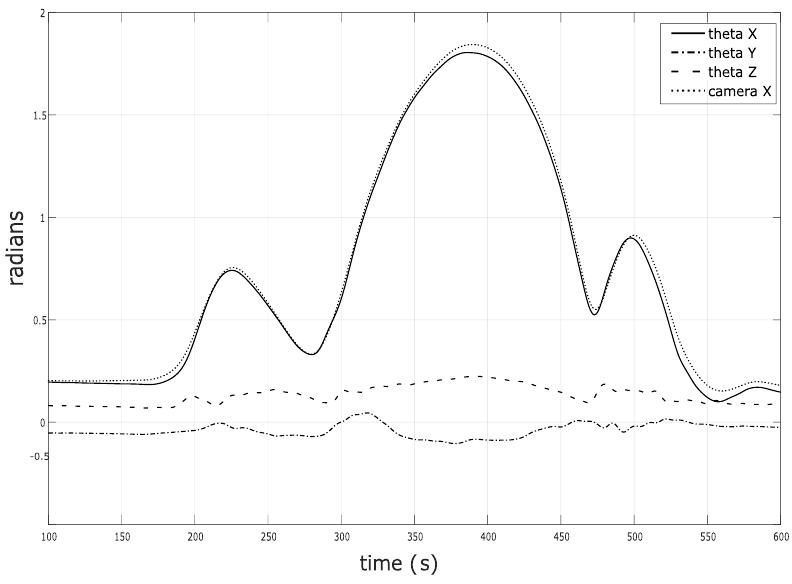
Figure 8. Estimated angles from a lunge movement. The estimated X (flexion/extension), Y (varus/valgus) and Z (internal/external rotation) Euler angles (thick, full, dashed, and dotted lines, respectively) are compared with the estimated angles obtained from the camera system (thin full